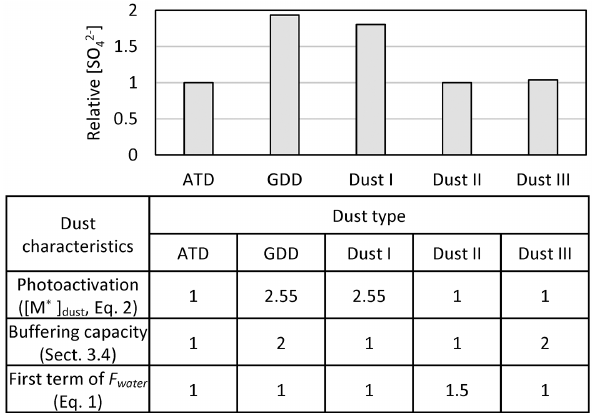
Figure 7. The analysis of the influential parameters associated with dust characteristics to form sulfate. The relative concentration of sulfate is predicted using AMAR in the presence of different types of dust including ATD, GDD, and three types of artificial dust (Dust I, II, and III). The variation of dust type is determined via three major aspects: photoactivation capability of dust linked to [ M ∗ ] in Eq. (2) (Sect. 3.3), the buffering capacity of dust (Sect. 3.4), and F water in Eq. (1) (Sect. 3.2). Dust types I–III are artificially for- mulated to analyze how the three dust properties can influence the sulfate formation. ATD is used as a reference dust. The three pa- rameters of GDD, which were obtained from experimental data, are scaled to those of ATD. For analysis, the simulation is con- ducted with 100µgm − 3 of initial dust particles, 40ppb of initial SO 2 , 2ppb of initial O 3 , and 10ppb of isoprene under ambient en- vironmental condition on 23 November 2017. The simulation was performed without considering the particle loss to the chamber